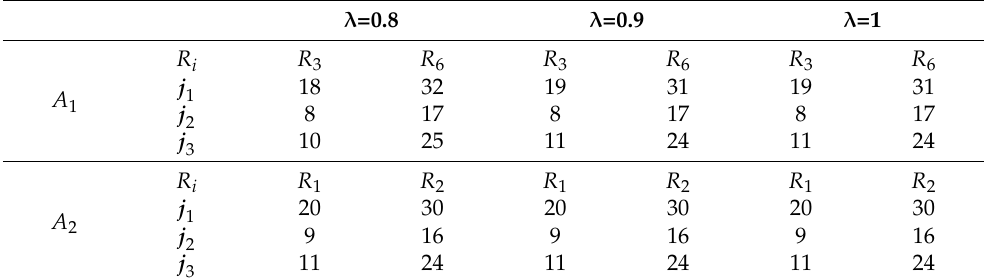
Table 6. Optimal decision-making quantities under different confidence levels in major accidents q 2 .